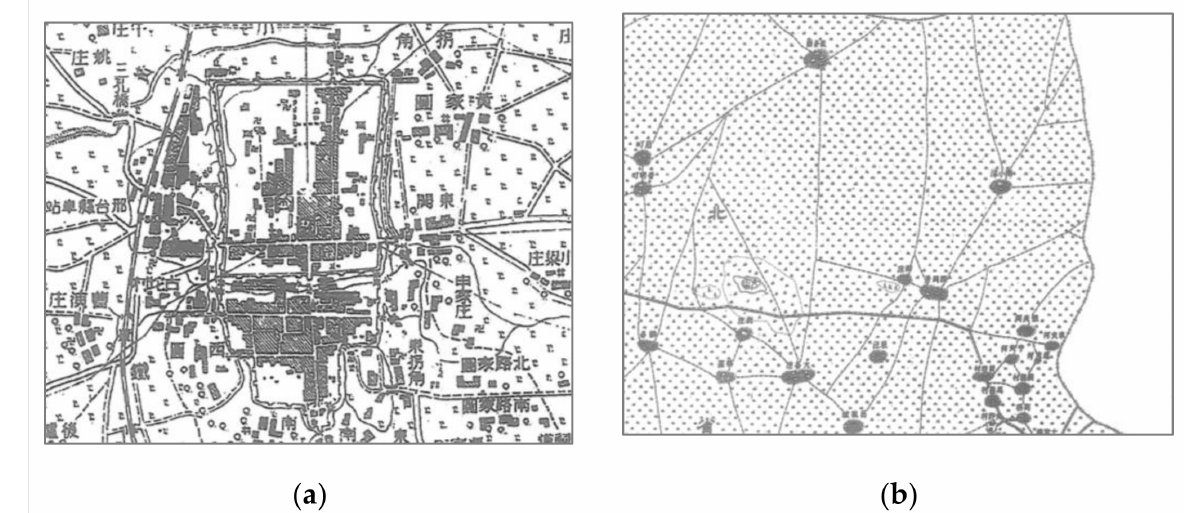
Figure 10. Cities and rural areas on the map: ( a ) City; ( b ) Rural